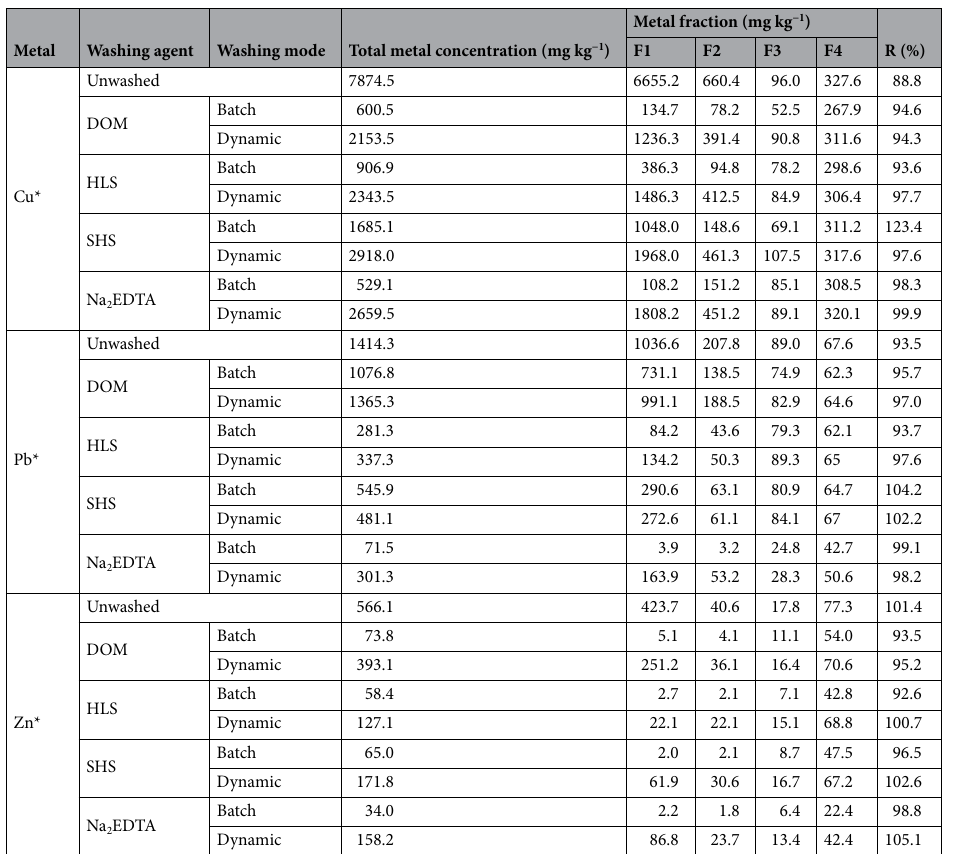
Table 2. Total metal concentrations and their individual fractions in soil before and after soil washing under batch and dynamic conditions. *Limit values for industrial soils in Poland: Cu 600 mg kg −1 , Pb 600 mg kg −1 , Zn 2000 mg kg −1 (OME 37 ), metal fractions: F1 is the exchangeable and acid soluble, F2 is the reducible, F3 is the oxidizable, F4 is the residual, R is the HM recovery